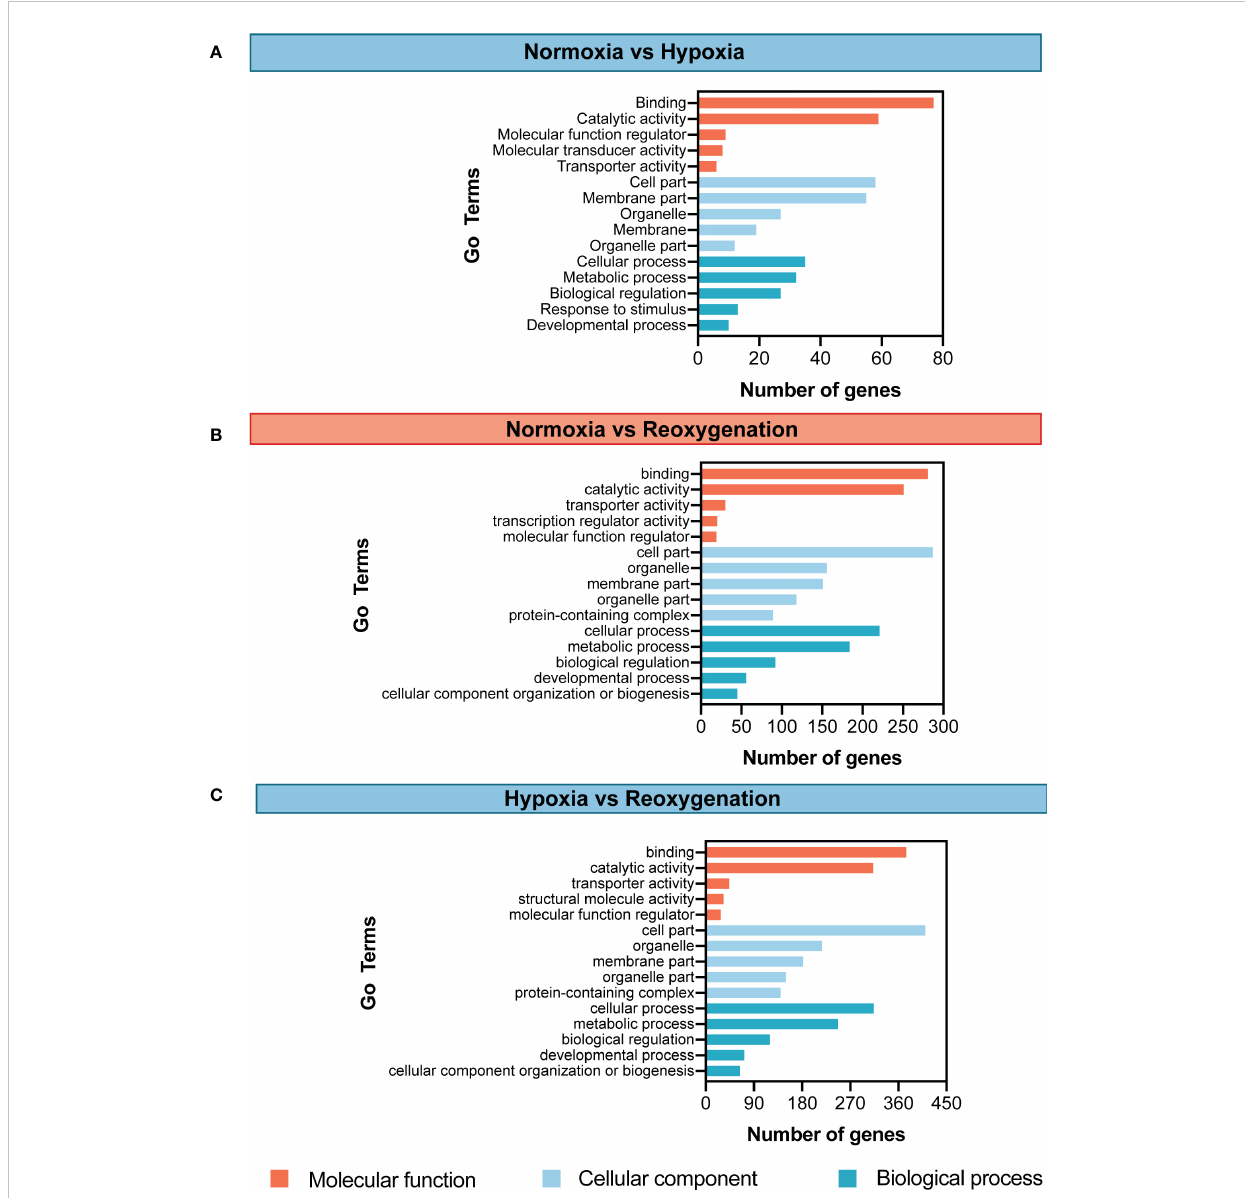
FIGURE 5 Annotation of differentially expressed genes. (A) GO annotation diagram for DEGs (normoxia vs hypoxia). (B) GO annotation diagram for DEGs (normoxia vs reoxygenation). (C) GO annotation diagram for DEGs (hypoxia vs